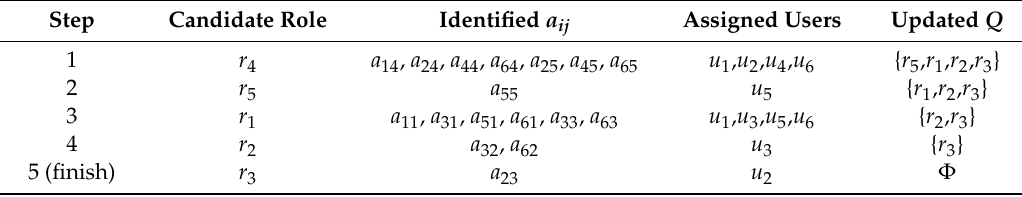
Table 17. The assigning